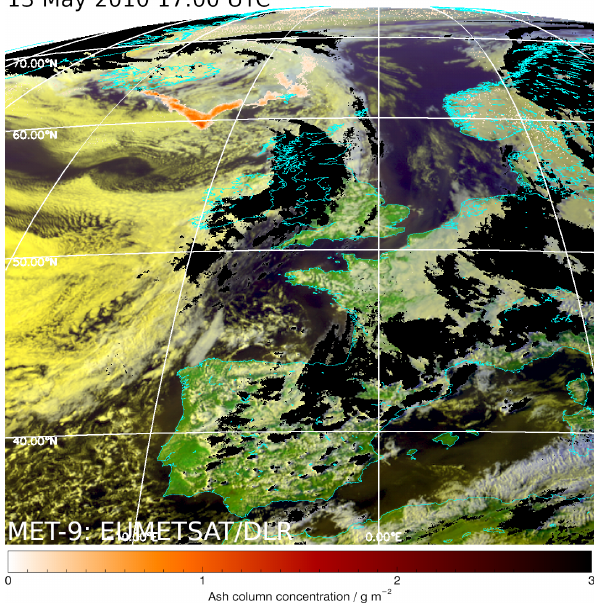
Figure 7. Ash column concentration from SEVIRI on 13 May 2010 (Eyjafjallajökull eruption, Iceland). Orange–red: ash detection (col- umn concentration); black: cirrus